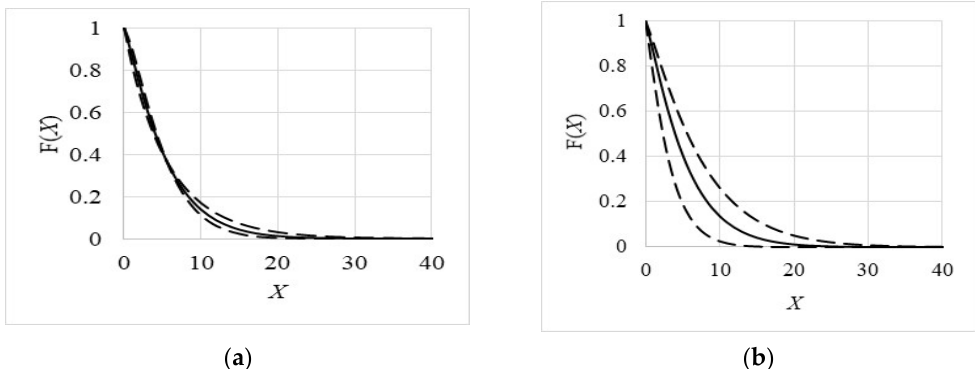
Figure 8. Weibull distribution function with the mean value of the parameter λ within the confidence interval of the parameter k ( a ) and with the mean value of the parameter k within the confidence interval of the parameter λ ( b ).